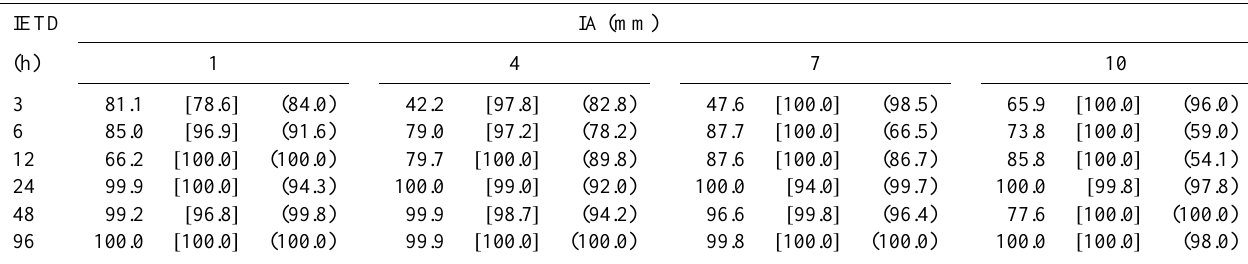
Table 4. p -values (%) obtained when testing the independence between the wet weather duration and the interevent period for the rainfall series of Brescia, Parma [.], and Naples (.). IETD IA